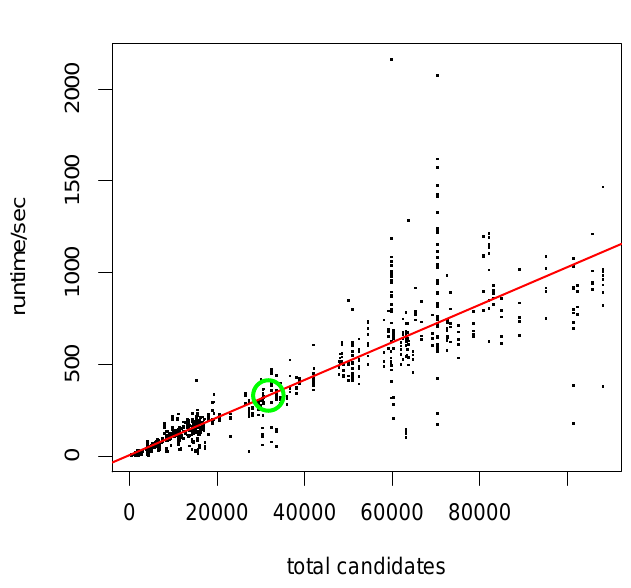
Figure 4: Runtimes of all candidate queries in the data set. The slope of the regression line is 10ms/candidate, the average (32 000 candidates in ≈ 5min) is